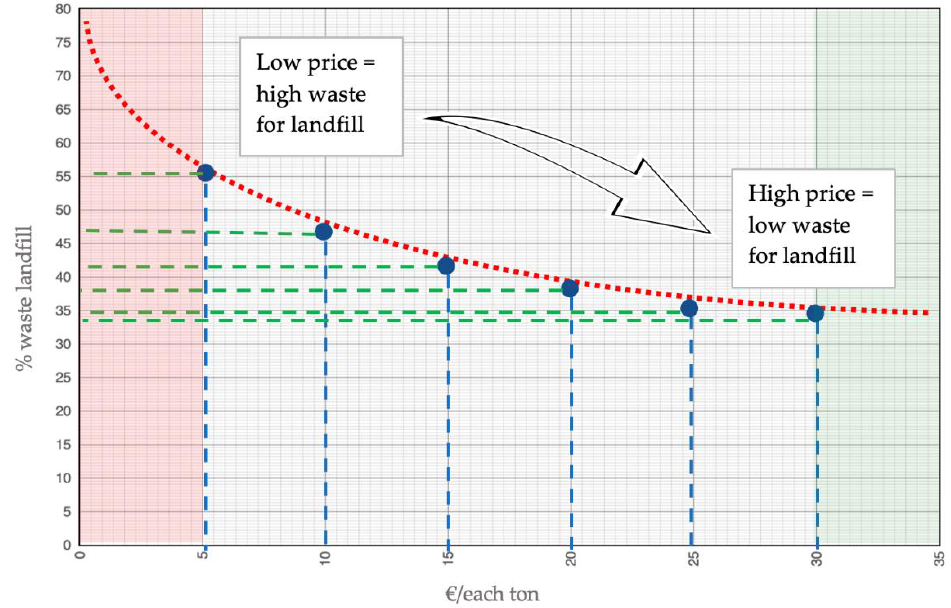
Figure 7. Relation between waste landfills in % and the charge for disposing waste from different Spanish areas. Source: elaboration with data collected from [34,35].